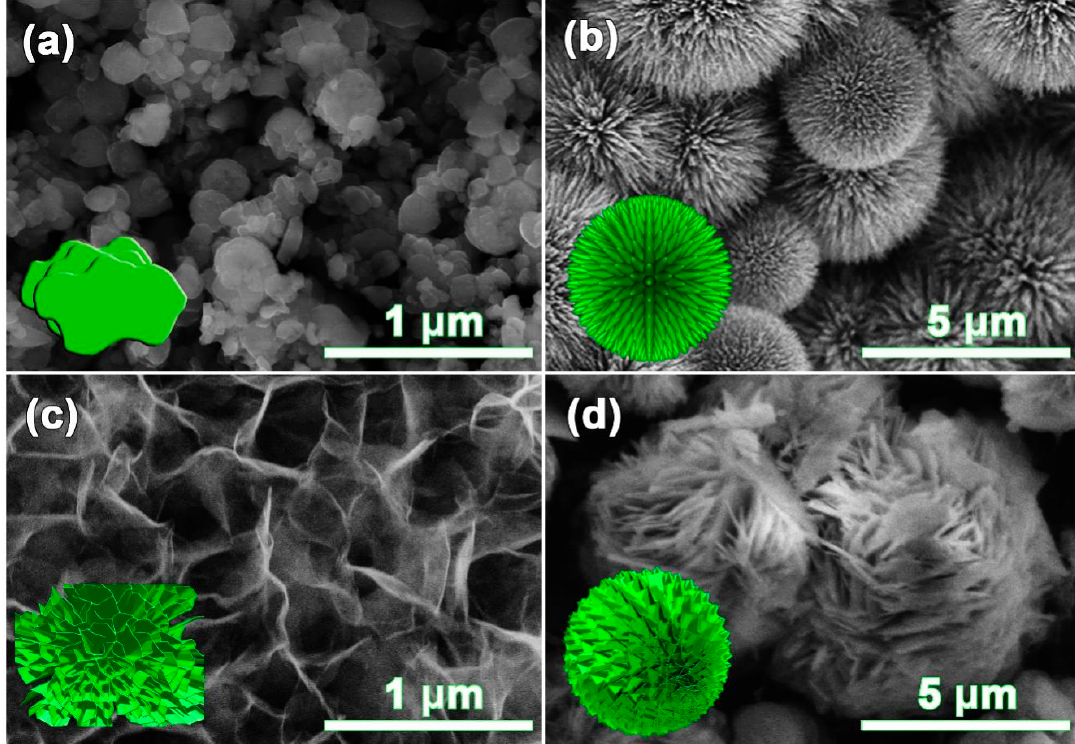
Figure 1. SEM images of β -NiS with different morphologies: ( a ) coral-like, ( b ) urchin-like, ( c ) flake-like and ( d ) flower-like.